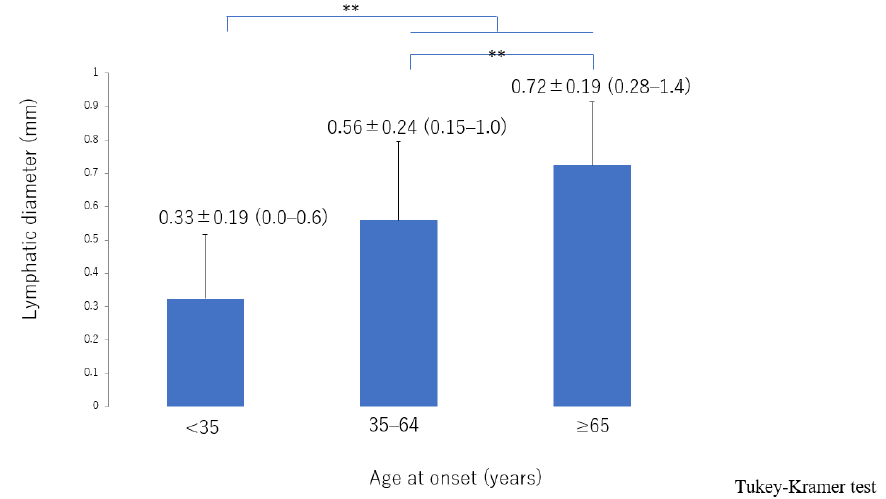
Figure 7. Lymphatic diameter according to age of onset. The lymphatic vessels became significantly more dilated with increasing age of onset from the <35 group, 35–64 group, through to the ≥65 group. ** p < 0.01 (Tukey–Kramer test).